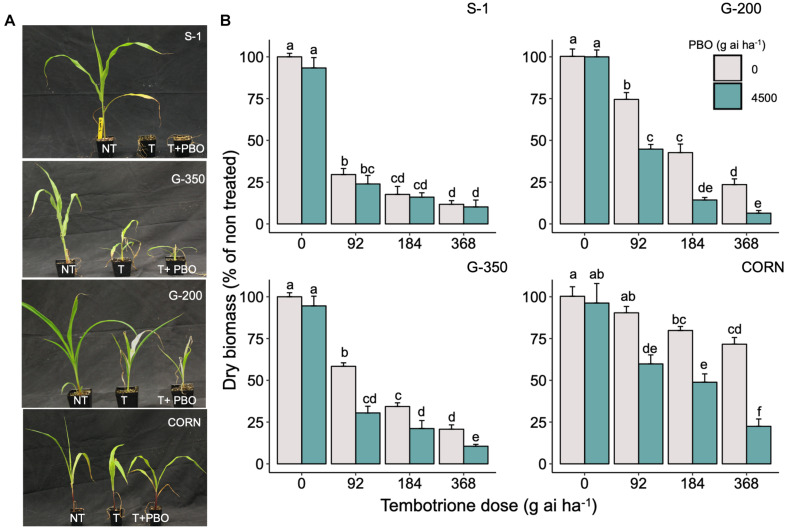
(A) The response of S-1 (susceptible), G-200, G-350 (resistant), and corn to field recommended dose of tembotrione (92 g ai ha–1) (T) or piperonyl butoxide (PBO) treatment (M1: 4,500 g ai ha–1) followed by field recommended dose tembotrione. NT: non-treated. (B) Above-ground dry biomass of sorghum genotypes when pre-treated with PBO or different doses of tembotrione. The error bars represent the standard error (n = 8); different alphabets indicate a significant difference between treatments (p ≤ 0.05).